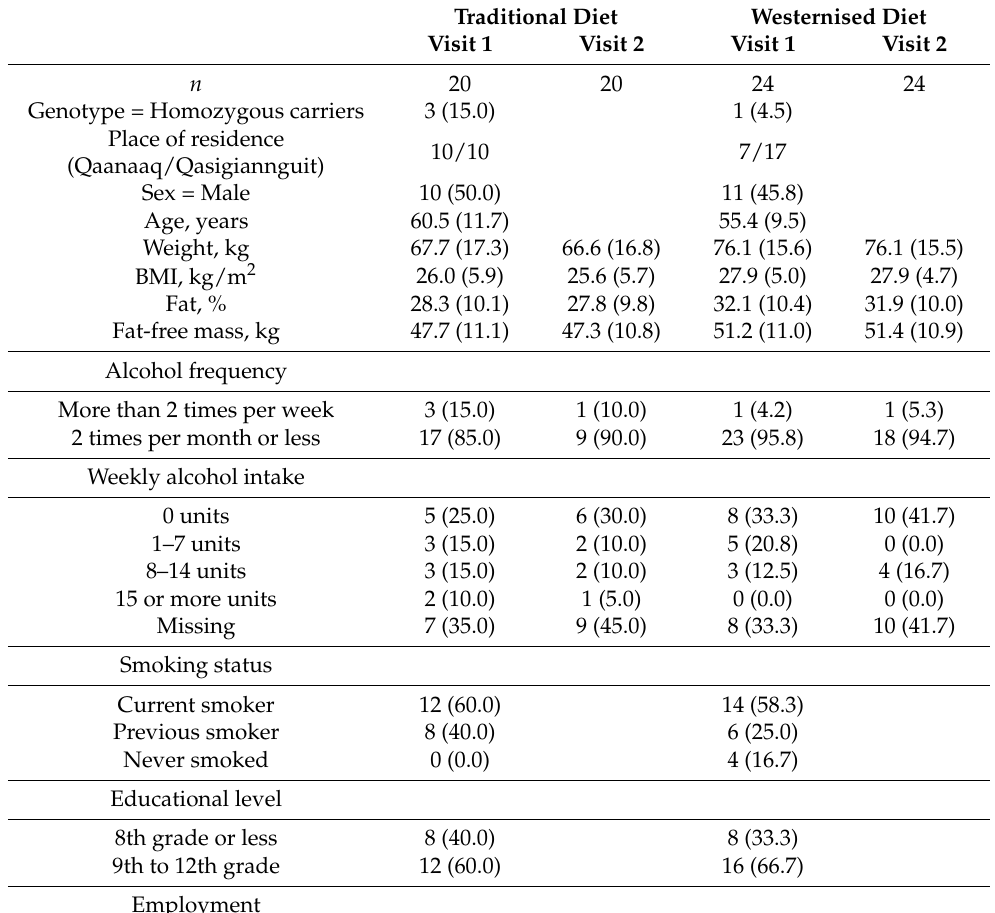
Table 1. Participants’ characteristics at baseline (visit 1) and after the intervention (visit 2) ( n = 44). Traditional Diet Westernised Diet Visit 1 Visit 2 Visit